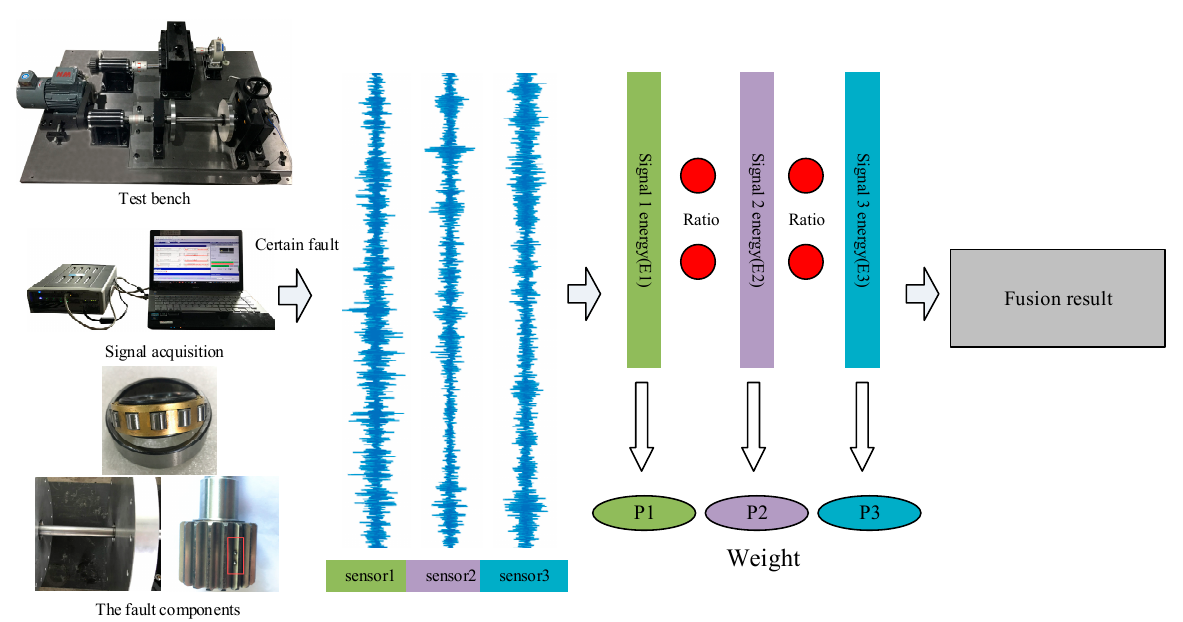
Figure 5. Steps of the fusion method.